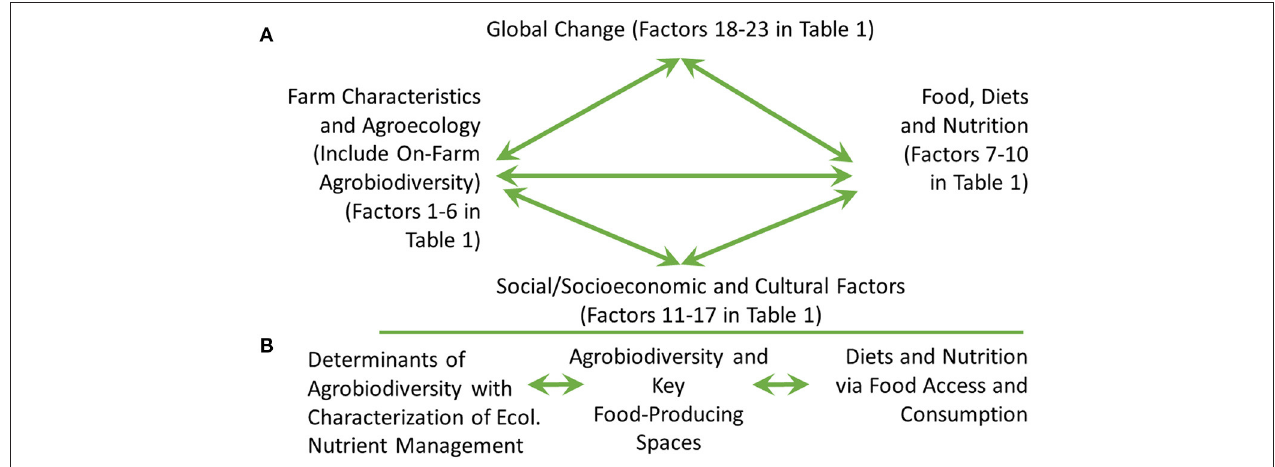
FIGURE 1 | (A) Conceptual model of themes of the Agrobiodiversity Knowledge Framework (AGK) with reference to enumerated factors in Table 1 . These AKF themes are linked to the specific factors in Tables 2 – 4 , with the illustrated AKF themes in this figure and the referenced factors serving as the connecting thread through the tables, text, and analysis. (B) Overview of agrobiodiversity-SDG research of this study (left-center) and related project